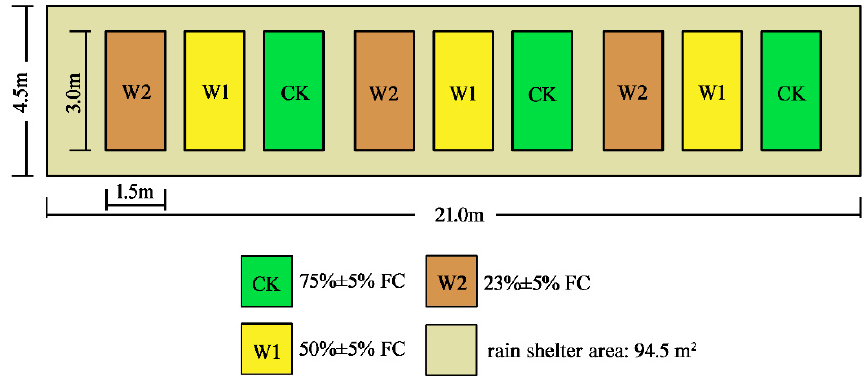
Figure 2. The area of the rain shelter and layout of different treatments. FC indicates the field water holding capacities.